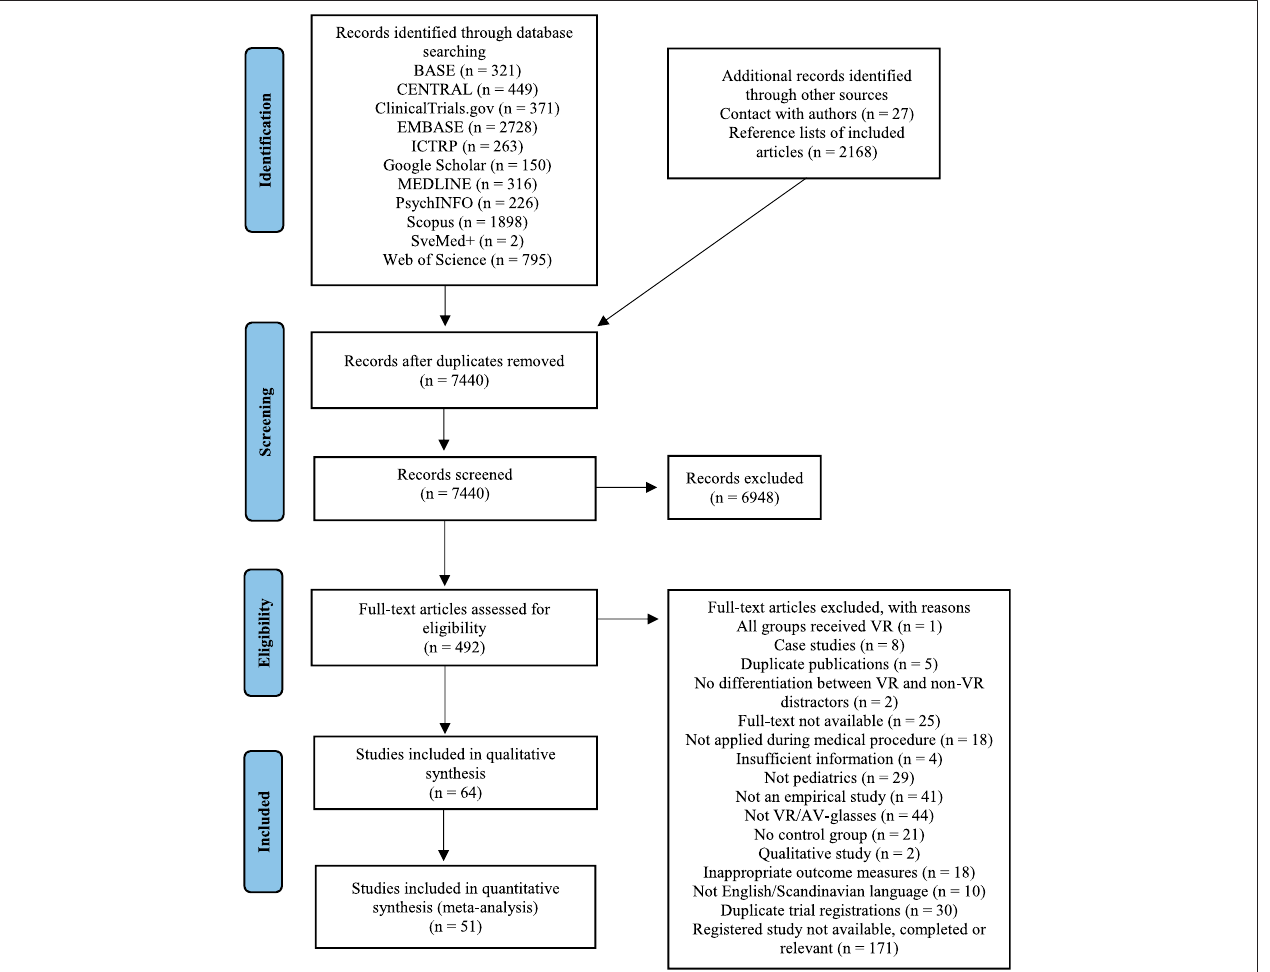
FIGURE 1 | PRISMA fl owchart showing the study selection